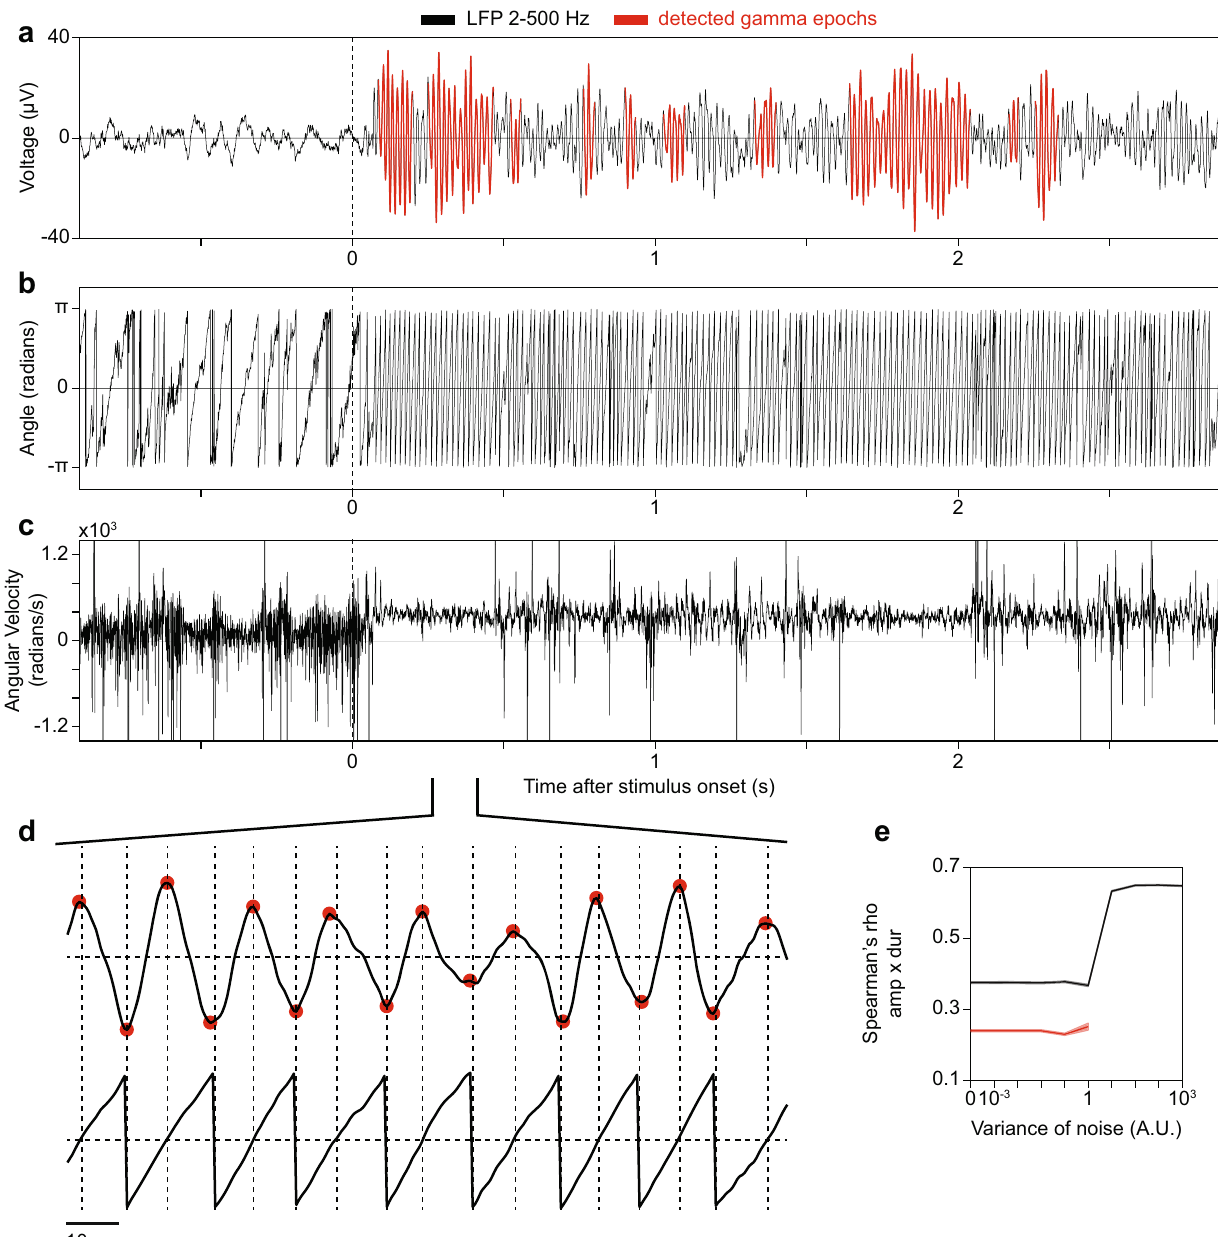
Fig. 3 Illustration of a method for the selection of gamma-oscillatory epochs. a LFP trace displayed in Fig. 1a, with regions presented in red corresponding to gamma epochs passing the criterion for stationarity. b Phase of the analytic signal based on the Hilbert transform of the trace shown in a . c Angular velocity of a . Note periods of positive and relatively stable angular velocity, corresponding to oscillatory gamma epochs in the original LFP. a – c Dashed lines indicate stimulus onset. d Magni fi cation of the designated section of the LFP trace and its phase. Red dots indicate detected LFP peaks and troughs. Vertical dashed lines designate negative- to- positive and positive-to-negative zero crossings of the phase of the analytic signal, whereas horizontal dashed lines designate 0. e The correlation between the amplitude of a gamma half- cycle and the duration of the same gamma half cycle for different additive noise levels, computed with the method used in Fig. 2 (black), and the method described in this fi gure (red). The error regions show ±2 SEM based on a bootstrap between the amplitude of a given half-cycle and the duration of trends may have contributed to the observed correlation between multiple preceding and succeeding half-cycles (Fig. 4b). Some gamma-cycle amplitude and duration. We therefore removed the datasets showed dynamics on the temporal scale of few half-cycles in fl uence of slower dynamics through a linear regression analysis (Fig. 4b, left), and others on the scale of multiple half-cycles (see Methods section). In this analysis, we fi rst regressed out (Fig. 4b, middle and right). For example, the right panel in Fig. 4b linear predictions of gamma-cycle amplitude and of duration shows a long-lasting, negative trend punctuated by a small from previous and succeeding cycles, obtaining regression resi- positive value for the instantaneous correlation. By contrast, the duals for amplitude and duration. We then repeated the analysis middle panel shows a positive trend peaking at zero lag. These of amplitude-duration correlations on these regression residuals